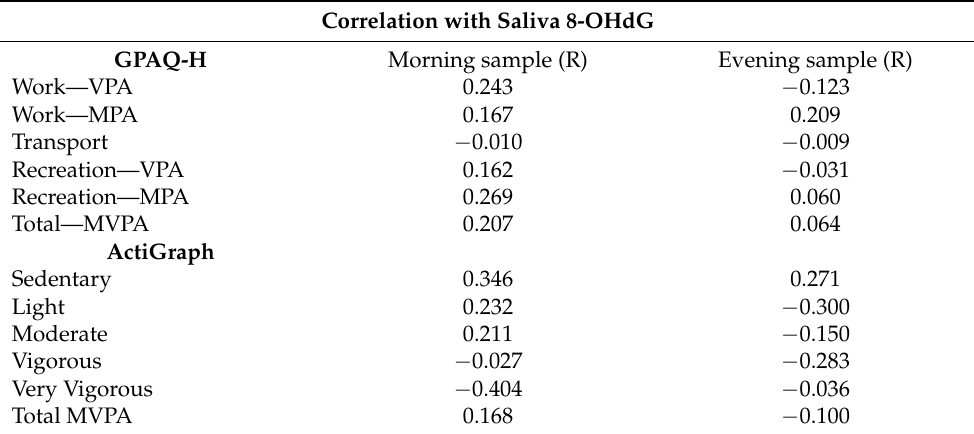
Table 5. Correlation between the types (work, active transport, recreation) and intensity of physical activity based on subjective and objective measures (GPAQ-H and ActiGraph GT3X, min/week) and the level of oxidative stress measured with saliva 8-OHdG (N =